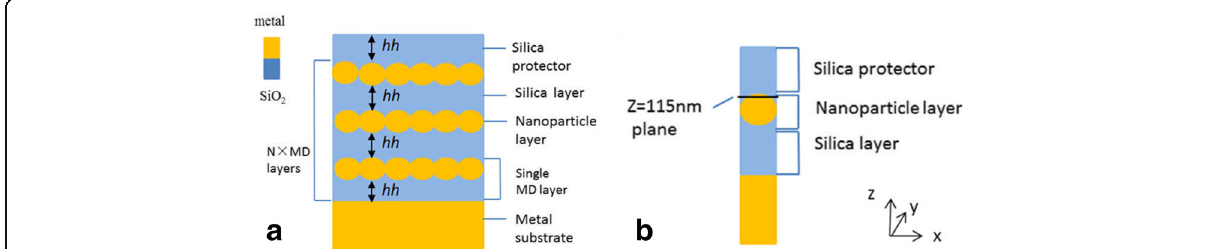
Fig. 1 a Basic structure of metal nanoparticle-dielectric absorber (NPA). All of the dielectric layers have a thickness of hh (100 nm). The diameter dd of metal nanoparticles is 20 nm. b One unit cell of the single-MD-layer NPA structure. Period P = dd = 20